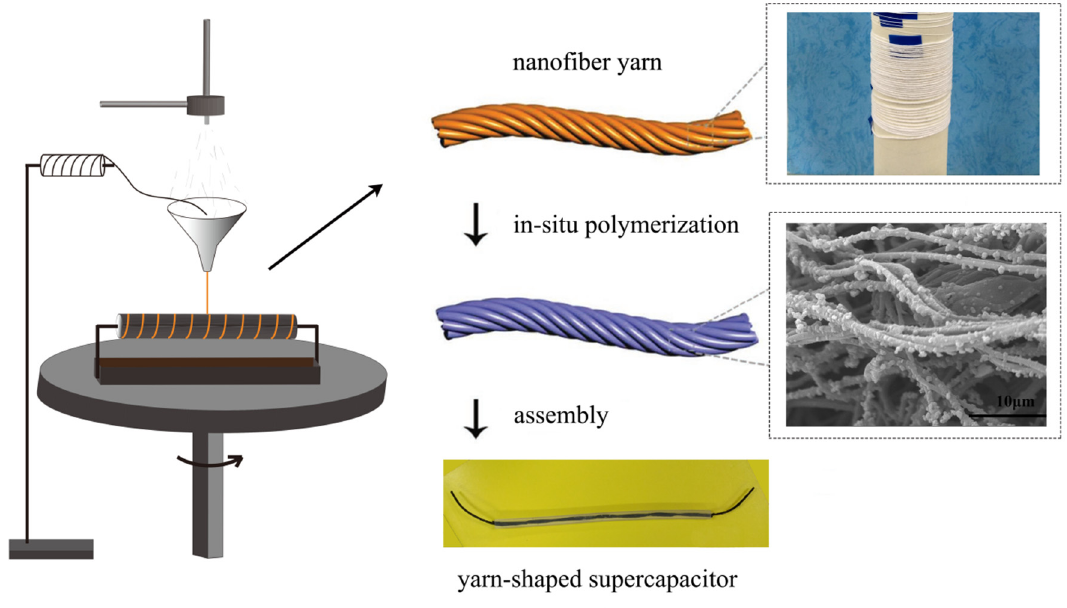
Figure 2. Process diagram of the supercapacitor based on CFs@PAN NFs@PPy.